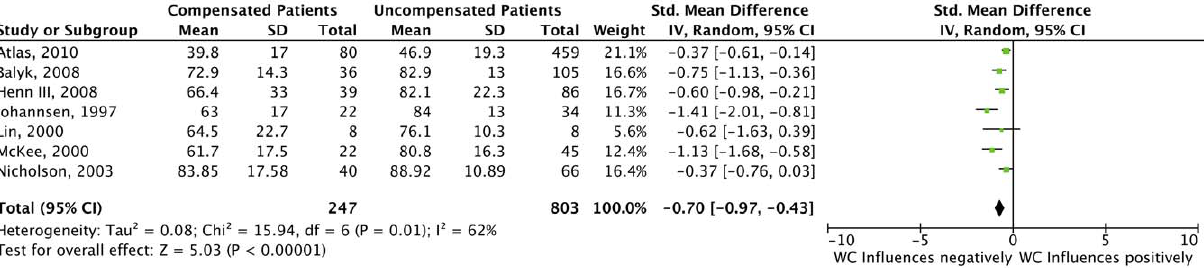
doi:10.1371/journal.pone.0050251.g004